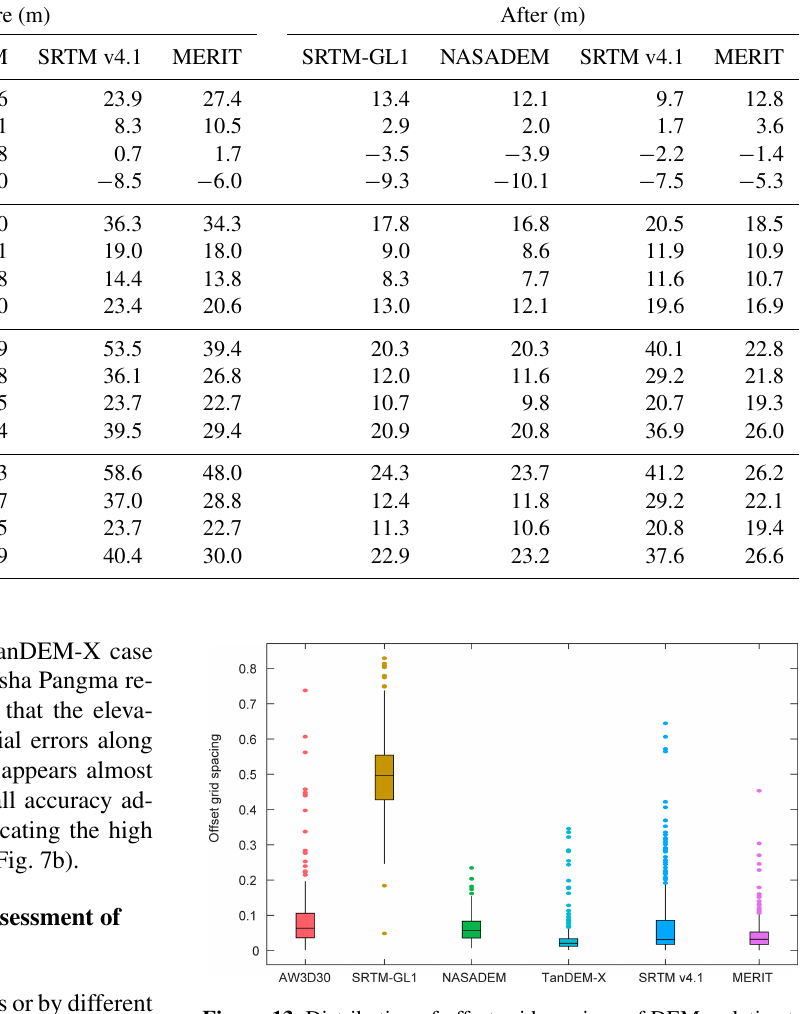
Figure 13. Distribution of offset grid spacings of DEMs relative to ICESat-2 on a 1 ◦ × 1 ◦ grid. Only the grid squares with R 2 greater than 0.5 and the number of records greater than 1000 are